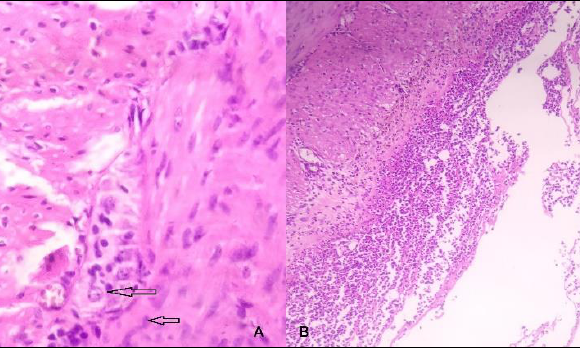
Figure 3: A) Mature as well as immature ganglion cells (arrow) are seen in the muscularis propria of ileum H & E stain. Original magni- fication X400; B) Prominent neutrophilic infiltration with suppura- tion is noted within the serosa of ileum. H & E stain. Original mag- nification